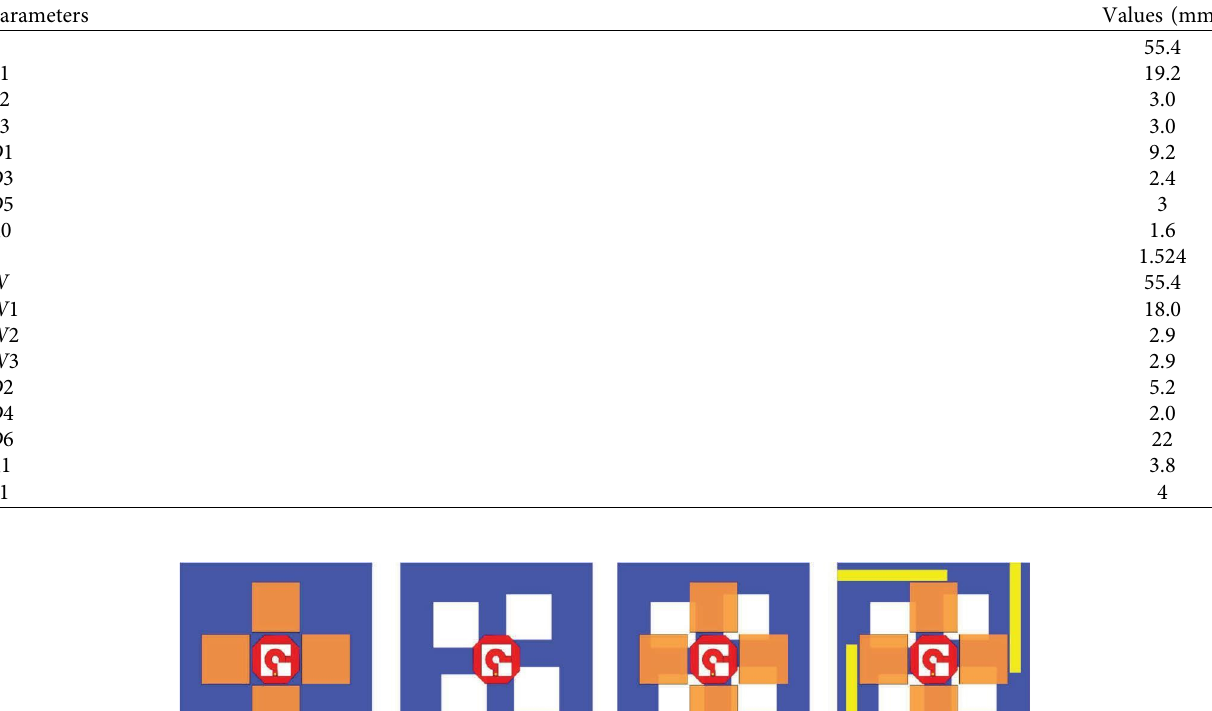
Table 1: Geometrical dimensions of the designed CP MPA.